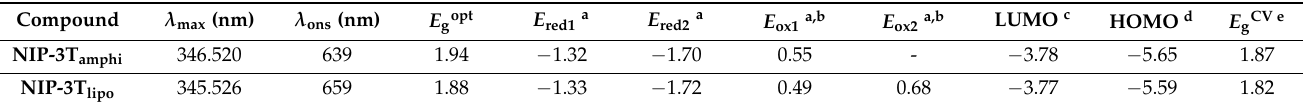
Table 8. Summed optical and electrochemical values obtained for the absorption and cyclic voltammetry measurements of NIP-3T amphi and NIP-3T lipo . Compound λ max (nm) λ ons (nm) Compound a Electrochemical potentials versus SCE in CH + couple). b Anodic potentials. c LUMO energy level estimated 2 Cl 2 (referenced to Fc/Fc from E LUMO = − ( E red1 + 5.1) (eV). d HOMO level estimated from E HOMO = − ( E ox1 + 5.1) (eV). e E gCV = E LUMO − E HOMO